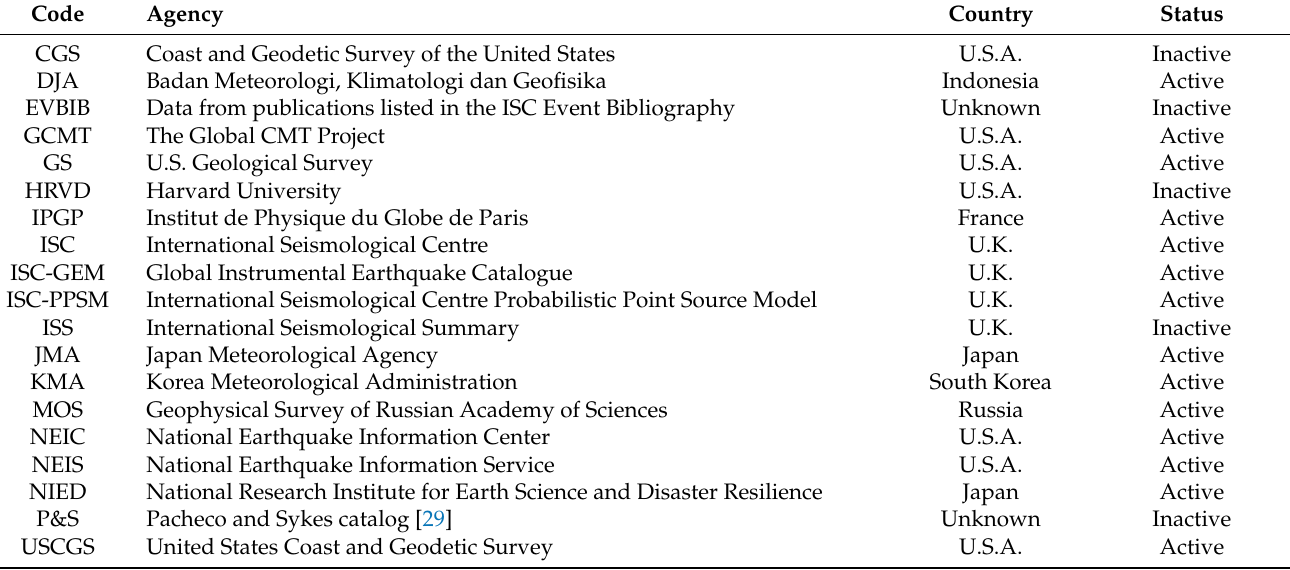
Table 1. Seismological agencies and projects that provided relevant earthquake data for this